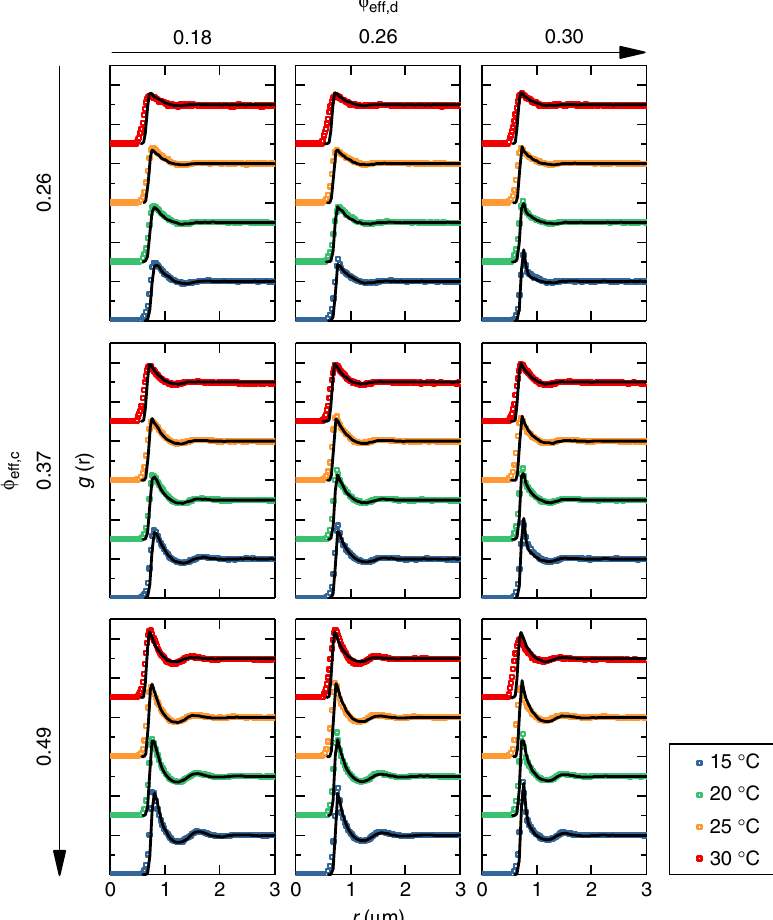
Fig. 3 Experimental and numerical structural correlations for all investigated binary mixtures. Experimental g ( r )s (colored squares) are compared to numerical ones (solid lines) based on the multi-Hertzian model. Data for different samples are offset in y for clarity. The color legend applies to the entire graph. Values of ϕ eff,c and ϕ eff,d at 15 °C are given for each row and column, respectively. For higher temperatures, the values of ϕ eff,c , ϕ eff,d can be found in